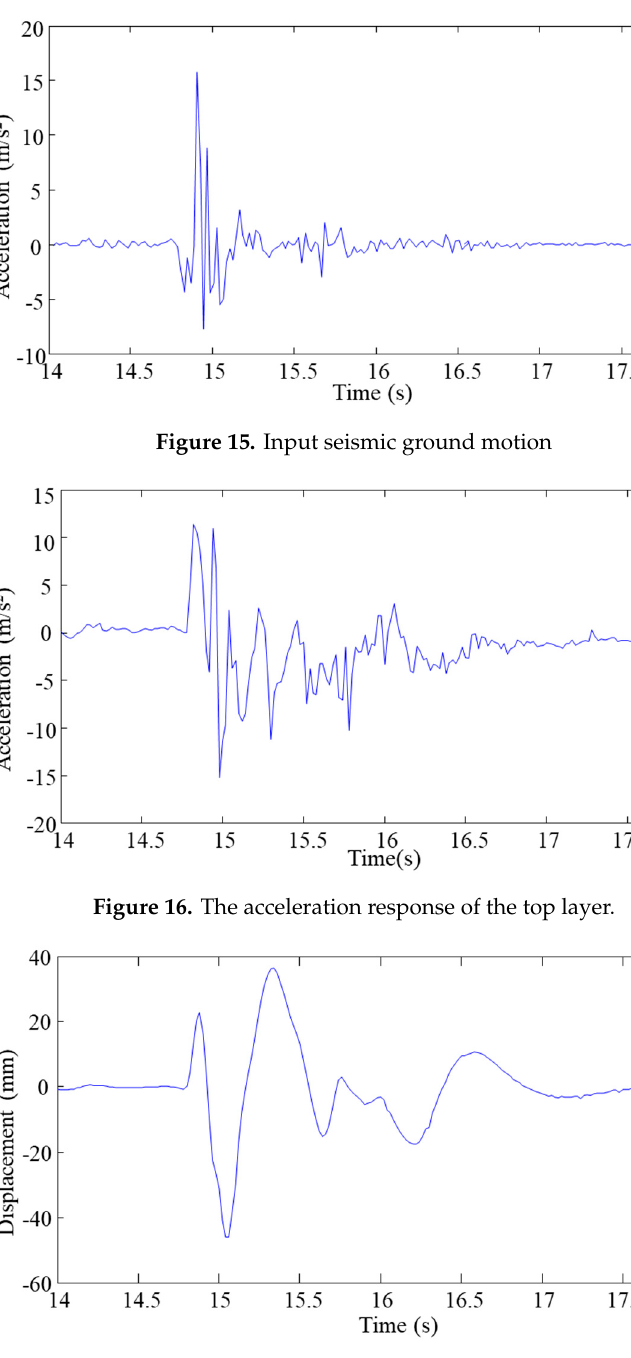
Figure 18. MR damper hysteretic curve. As can be seen in figures above, in the event of a nine-magnitude earthquake (peak acceleration is 1.5 g), the peak displacement of the isolation layer reaches 46 mm, which is close to 250% shear deformation, but the maximum shear deformation is not up to the limit of 300% in the code. At this point, the damper hysteresis curve area reaches the maximum and the energy consumption is the largest. The main part of the structure has entered into the plastic state, but there has not been the phenomenon of overall inclination and collapse. All of this depends on the MR damper’s ability which can achieve larger energy dissipation instantaneously. Figure 19 displays the failure of structural members.